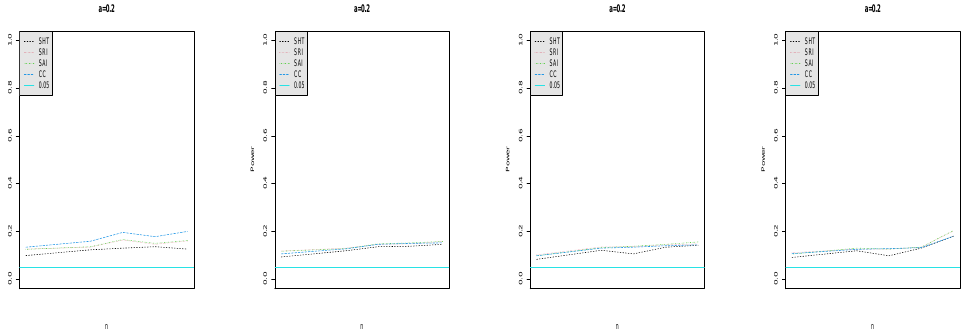
Figure 1. SHT, SRI, SAI and CC represent empirical powers evaluated from IPW, regression impu- tation, AIPW and CC methods against the sample size n under balanced design with missingness data mechanism models E1 ( left panel ), E2 ( left second panel ), E3 ( right second panel ) and E4 ( right panel ) for a = 0.2.